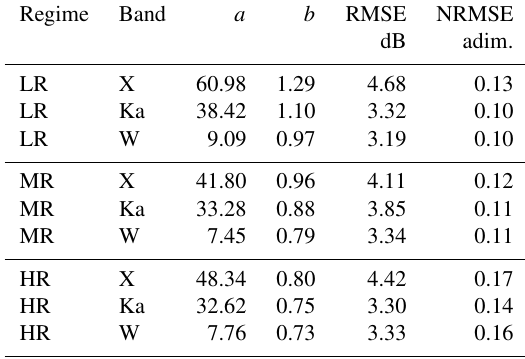
Table 2. Empirical Z e – S for the four snow cases divided into LR, MR and HR snowfall regimes as shown in Figs. 4–6. Z e – S at X, Ka and W band derived from ARM radar and PIP video disdrometer using a least-squares regressive analysis in the log–log space for each riming regime. The root-mean-square error (RMSE) is also shown in addition to the normalized RMSE (NRMSE) for the value range (defined as the maximum value minus the minimum value) of the measured data. The variability of coefficients, a and b , is shown in Fig. 7. Coefficients are related to the Z e – S reference model in power-law form, i.e., Z e = aS b , where Z e is expressed in mm 6 m − 3 and S is in mmh − 1